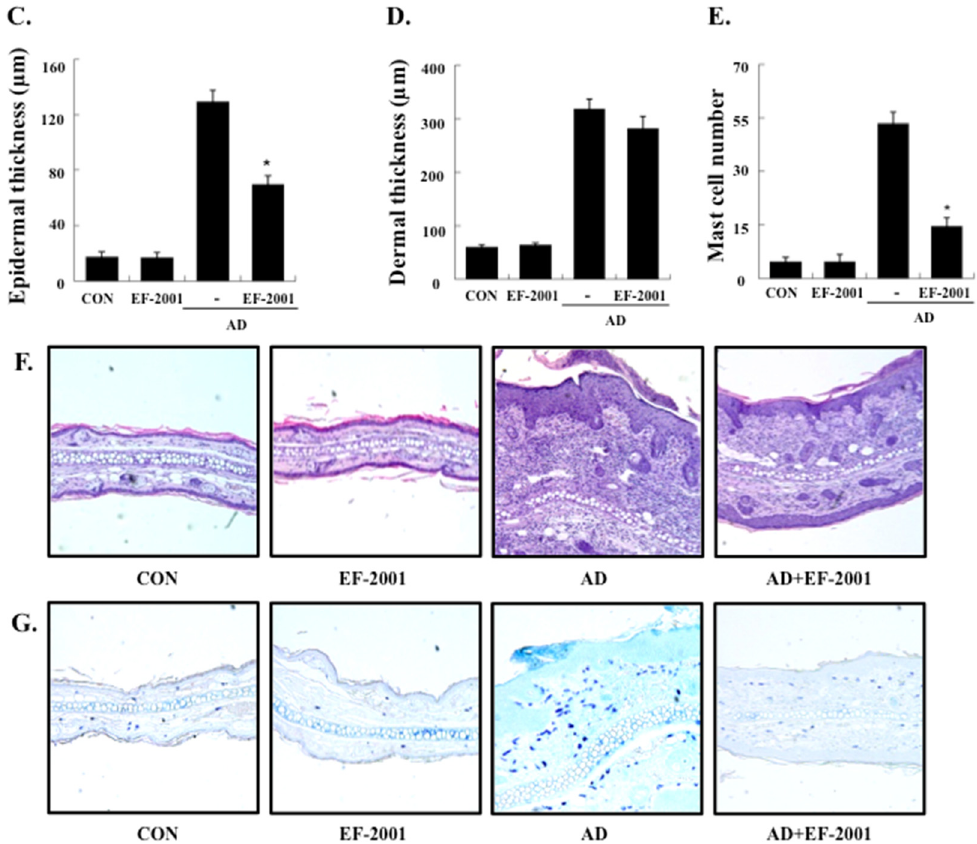
Figure 2. Histopathological analysis to assess the effect of EF ‐ 2001 on the ear thickness and mast cell infiltration. ( A ) The ear thickness was measured 24 h after 2,4 ‐ dinitrochlorobenzene (DNCB) or Dermatophagoides farinae extract (DFE) application with a dial thickness gauge; ( B ) Photographs of the ears of mice from each group on day 28; Epidermal ( C ) and dermal ( D ) thickness was measured from hematoxylin and eosin ‐ stained microphotographs; ( E ) The number of infiltrated mast cells was determined on the basis of toluidine blue staining; Representative photomicrographs of ear sections stained with hematoxylin and eosin ( F ) or toluidine blue ( G ). Data are presented as the mean ± SD of six determinations of each group ( n = 6). * Significant difference from the DFE/DNCB ‐ treated value at p < 0.05. The pictures shown are representative of each group ( n = 3–6). Original magnification was 200×. CON, control; EF ‐ 2001, heat ‐ killed Enterococcus faecalis EF ‐ 2001; AD, atopic dermatitis